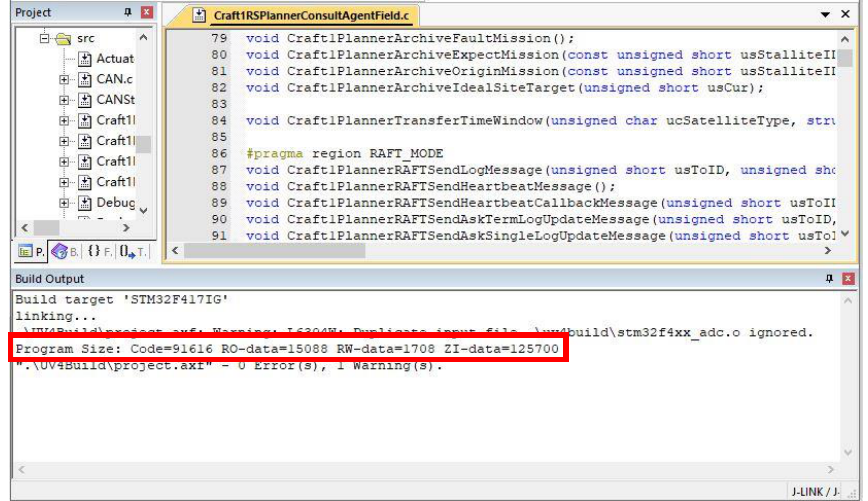
Figure 7. Compilation results of the planner component simulation program including the RAFT algorithm.